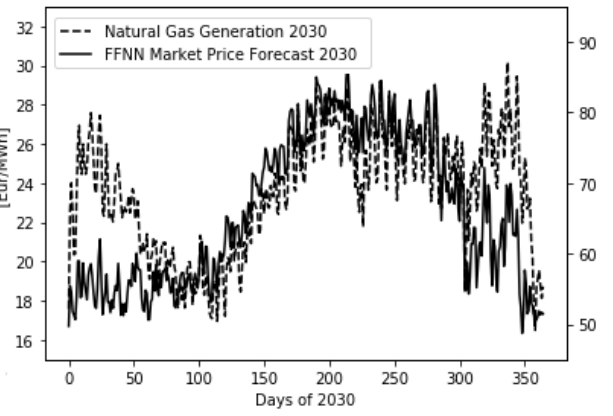
Figure 8. Hydro, solar, and wind (renewables) versus natural gas generation for 2030 in MIBEL.